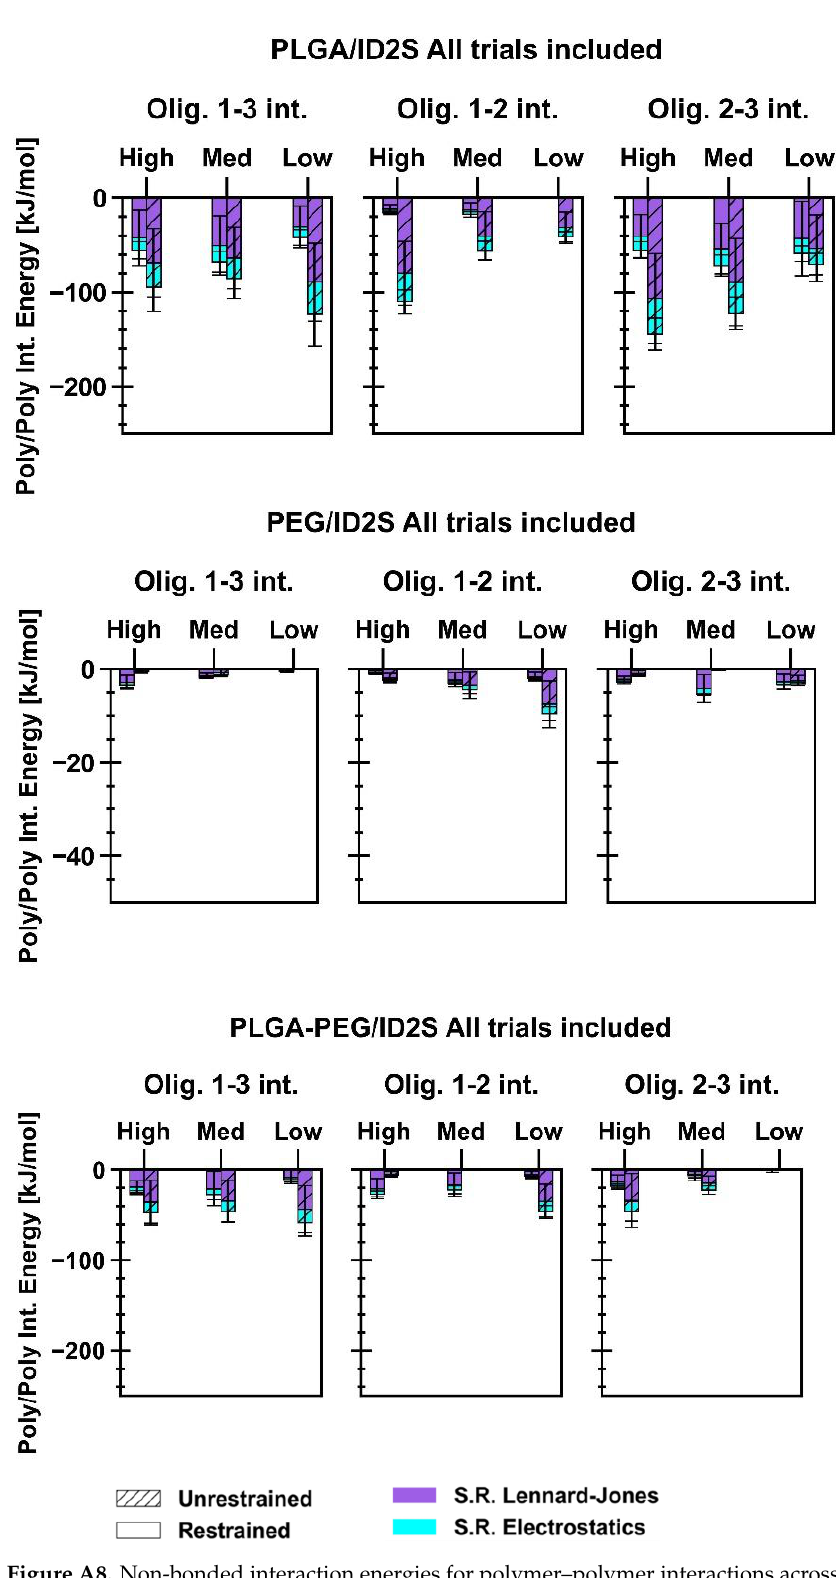
Figure A7. Oligomer-averaged time frequency of each interaction class, for each simulation trial across the different polymer types. Both restraint-on and -off phases were accounted for in the cal- culation of TF. These mean values were used to calculate TF avgpoly , as seen in the Results and Discus- sion section.